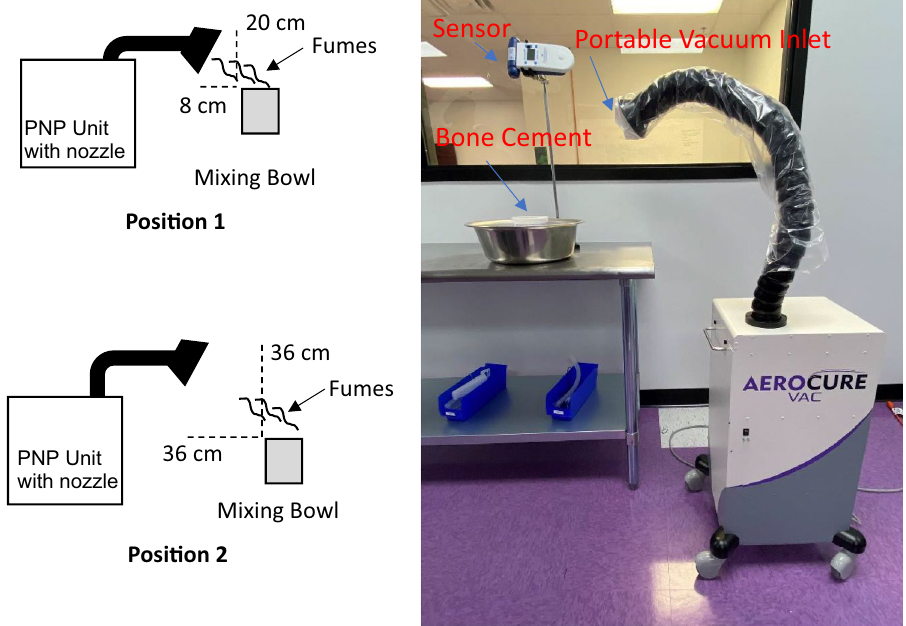
Figure 2. The experimental set-up contains a PNP unit (positioned at two distances), VOC sensor and bone